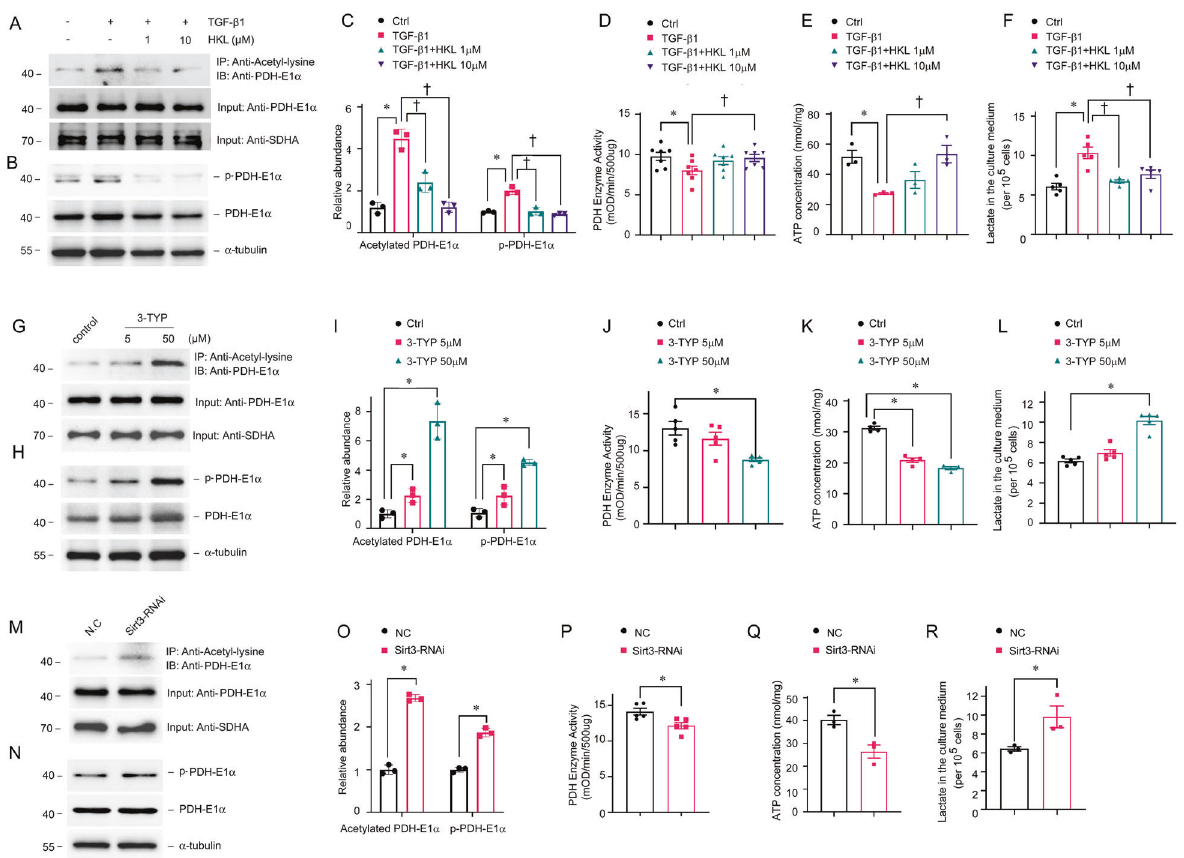
Mitochondrial lysates immunoprecipitated with anti-acetyl-lysine antibody and analyzed with anti-PDHE1 α . ( A , C , G , I , M , O ). PDHE1 α served as the standard (* P < 0.05, † P < 0.05; n = 3). Western blots of phosphorylated and total PDHE1 α expression in TEC lysates ( B , C , H , I , N , O ). PDHE1 α served as the standard (* P < 0.05, † P < 0.05; n = 3). Enzyme activity of PDH in TECs incubated with or without HKL, then stimulated with TGF- β 1 (* P < 0.05 vs. control, n = 7; † P < 0.05 vs. TGF- β 1, n = 7) ( D ), or 3-TYP (* P < 0.05 vs. vehicle, n = 5) ( J ), or transfected with Sirt3 siRNA (* P < 0.05